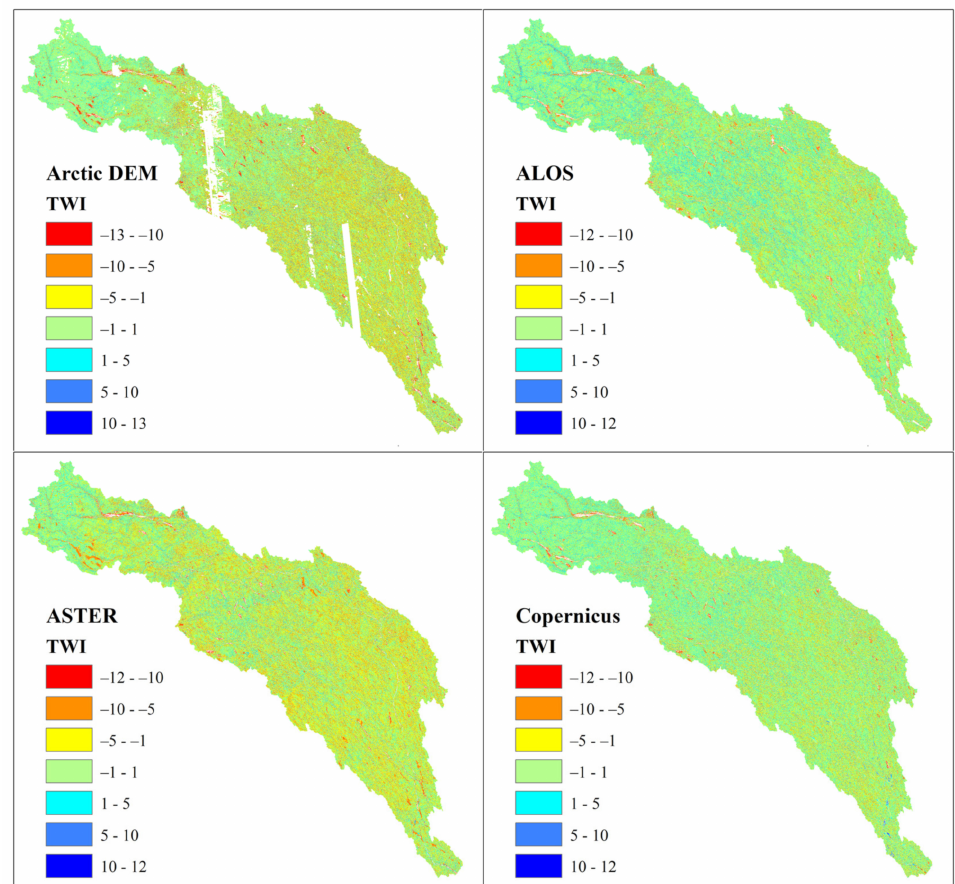
Figure 4. Difference maps of TWI from four candidate DEMs when compared with TWI derived from the reference